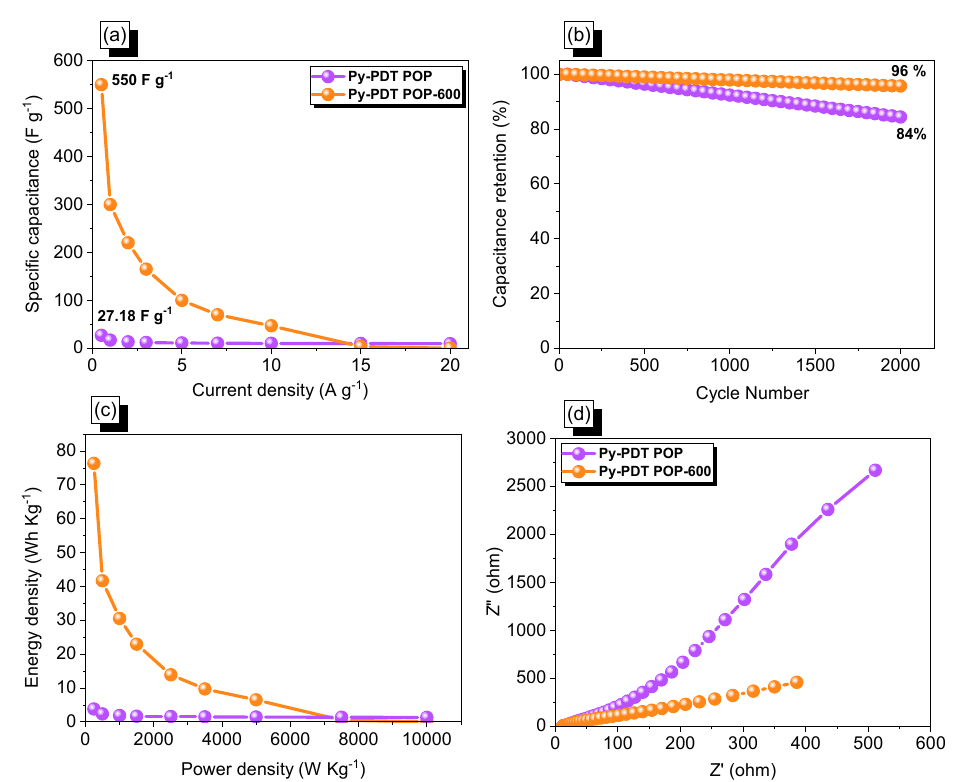
Figure 8 . Capacitance (a) and cycling stability (b), Ragone (c) and EIS (d) profiles of Py-PDT POP and Py- Figure 8. Capacitance ( a ) and cycling stability ( b ), Ragone ( c ) and EIS ( d ) profiles of Py-PDT POP PDT POP-600. and Py-PDT